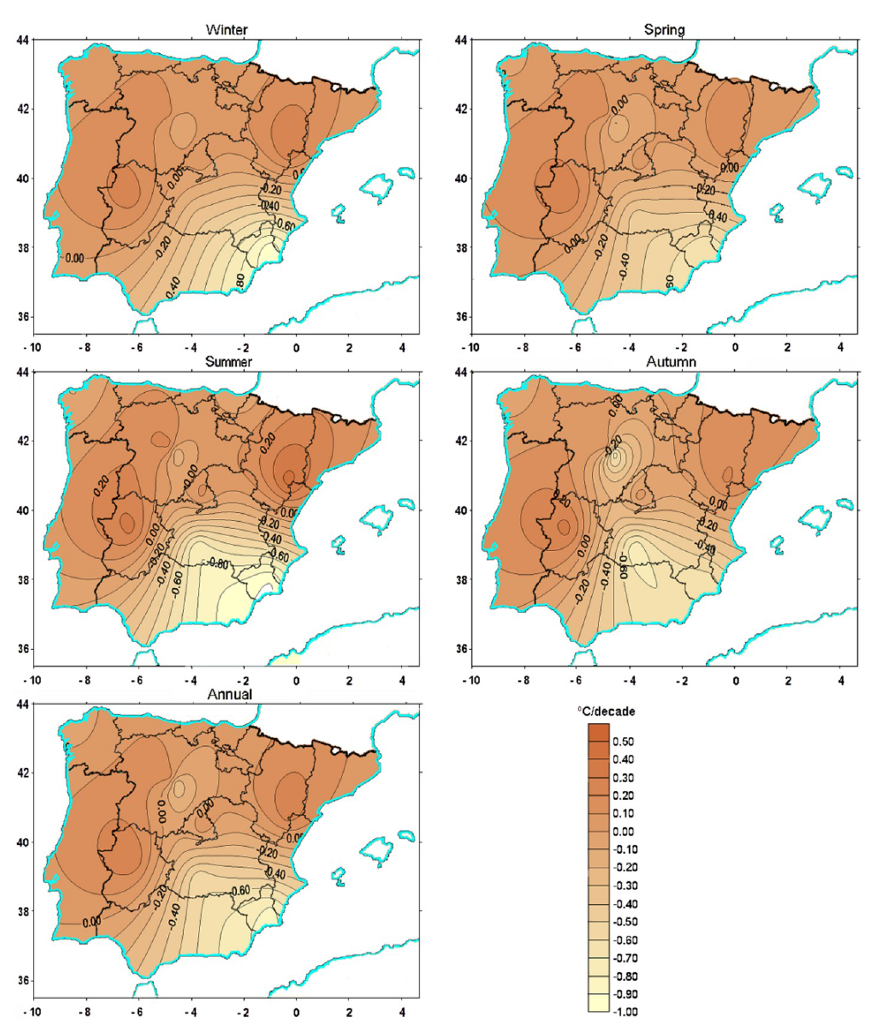
Figure 6. Isolines of seasonal and annual trends in diurnal temperature range (DTR) in Spain over the period 1950–2011, expressed in °C decade -1 .